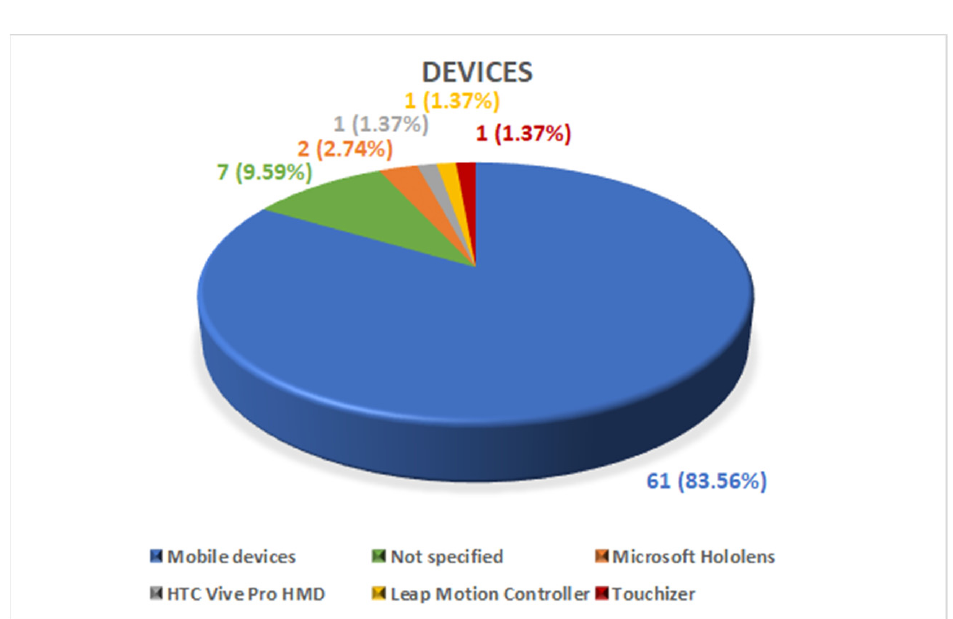
Figure 7. Empirical studies: devices used.